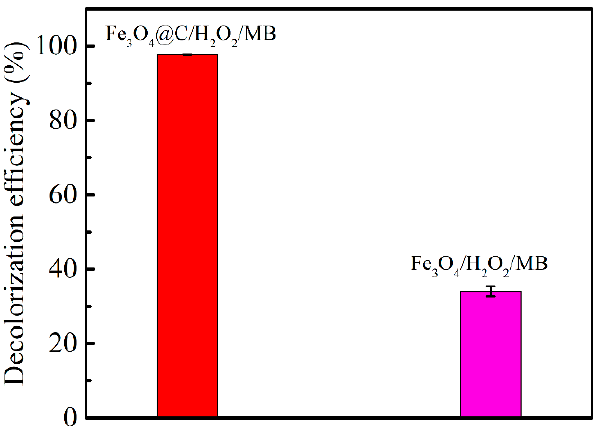
Figure 7. Comparison of Fenton-like catalytic activity between Fe 3 O 4 @C nanoparticles and pure Fe 3 O 4 nanoparticles.